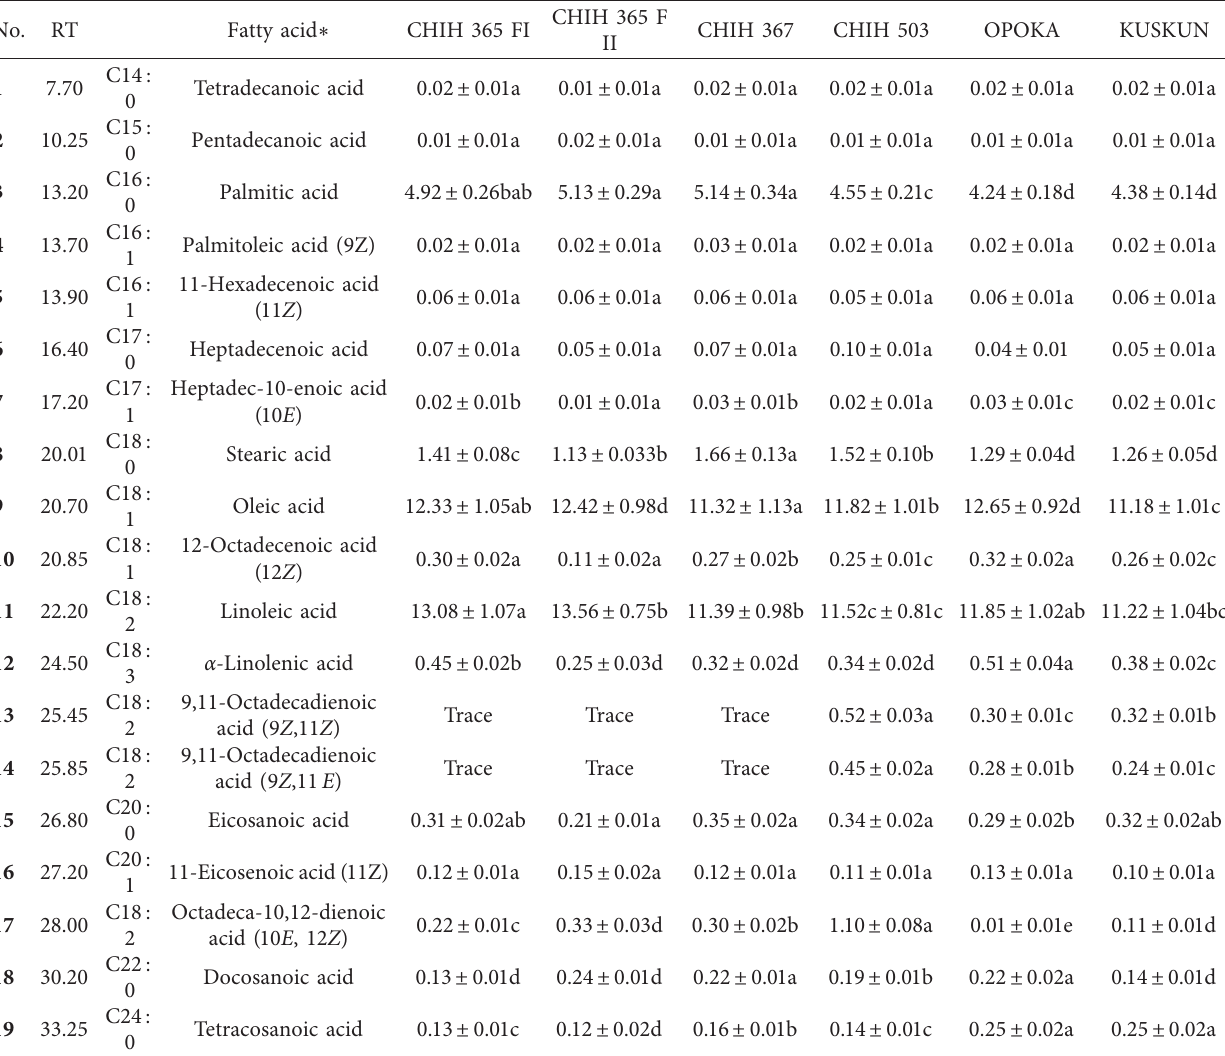
Table 1: Fatty acid profile quantified (g/kg) in the BCE and Fraction II.